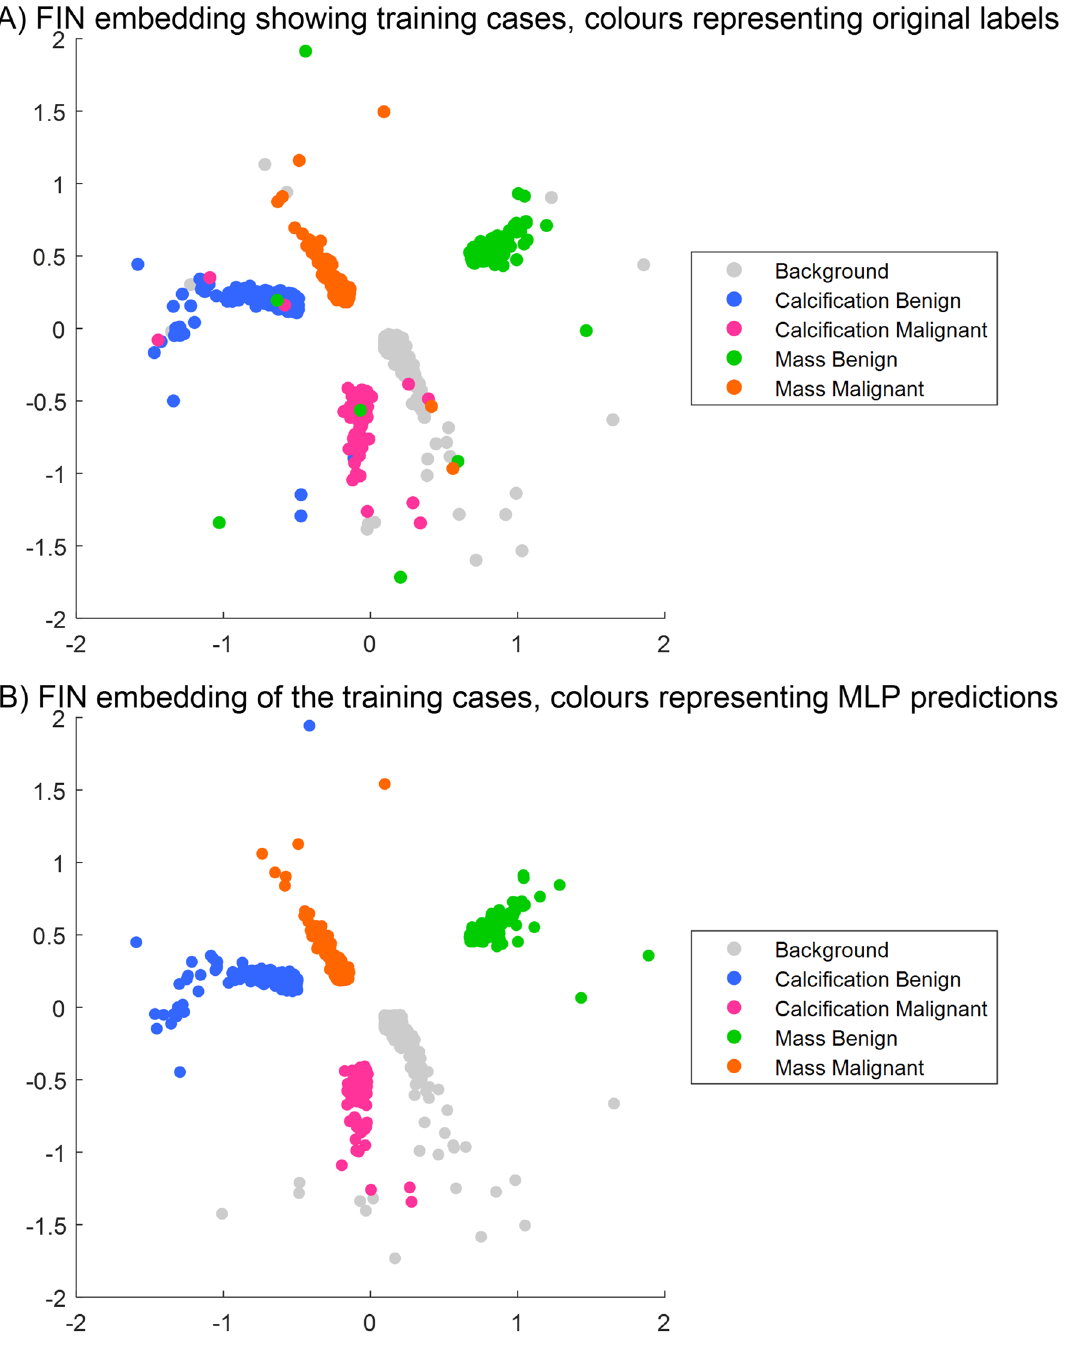
Figure 4. Visualisation of the training cases in the latent space of the FIN embedding. Cases/patient mammograms are represented by points: ( A ) colours representing the true, original labels; ( B ) colours representing the MLP prediction